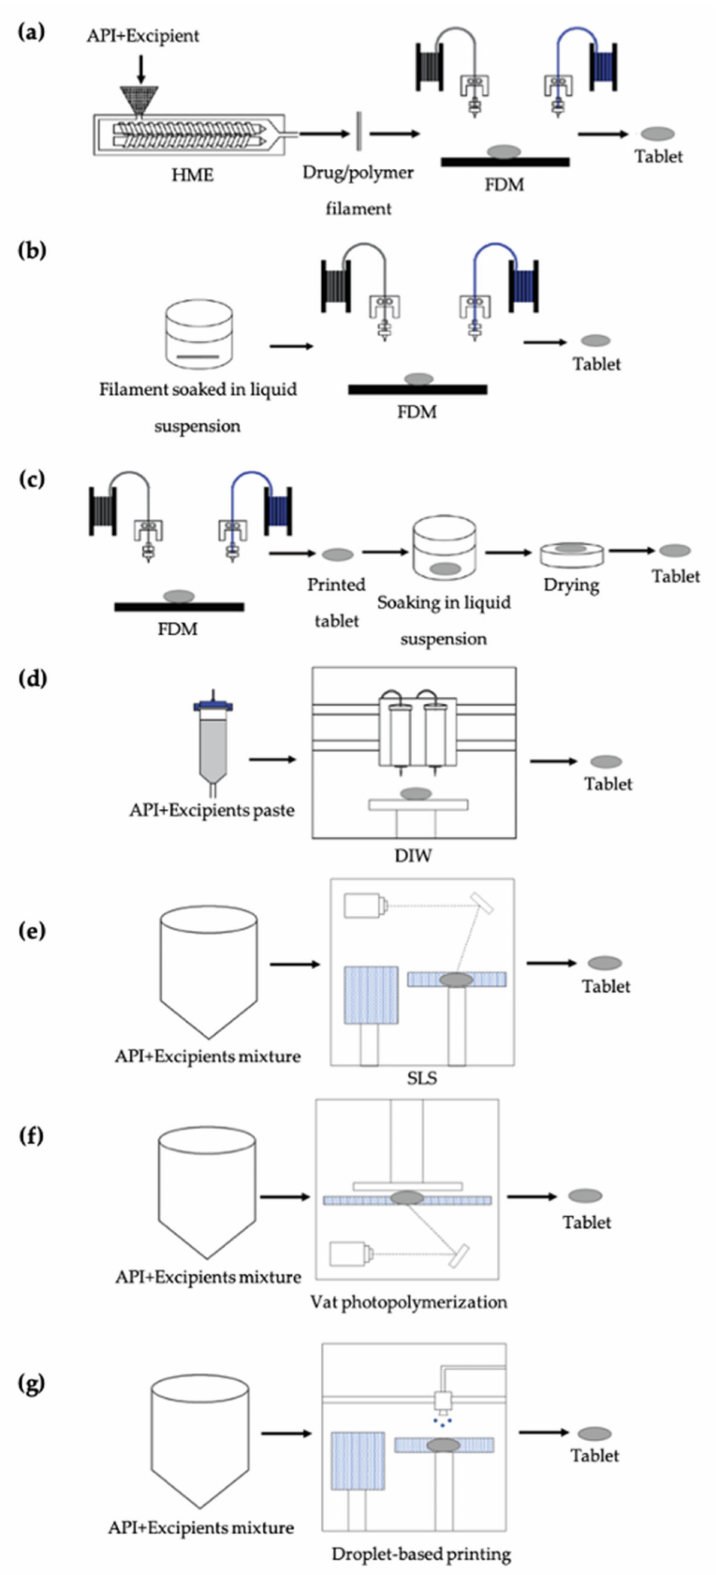
Figure 2. Processes using different 3D printing technologies to produce 3D-printed tablets: ( a ) FDM printing using drug-loaded filaments produced with HME; ( b ) FDM printing with filaments (without APIs); ( c ) FDM printing using drug-infused filaments; ( d ) DIW of drug formulation in the form of a paste; ( e ) SLS printing; ( f ) droplet-based printing; ( g ) vat photopolymerization-based